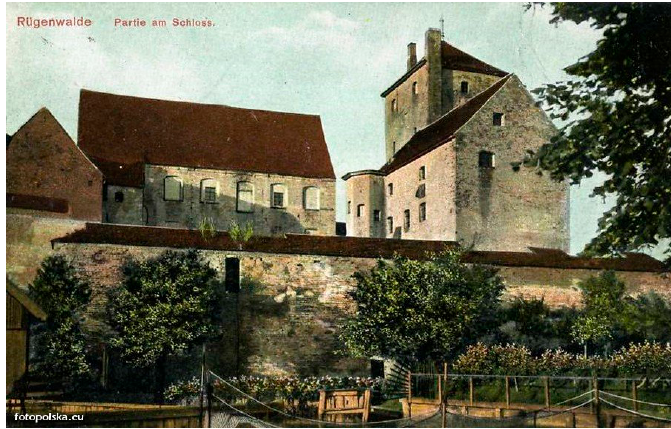
Figure 11. The Pomeranian Dukes’ Castle in Dar ł owo in the interwar period, source: fotopolska.eu.